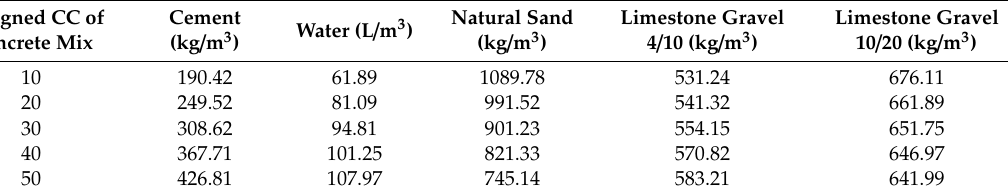
Table 3. Tested concrete mix recipes.